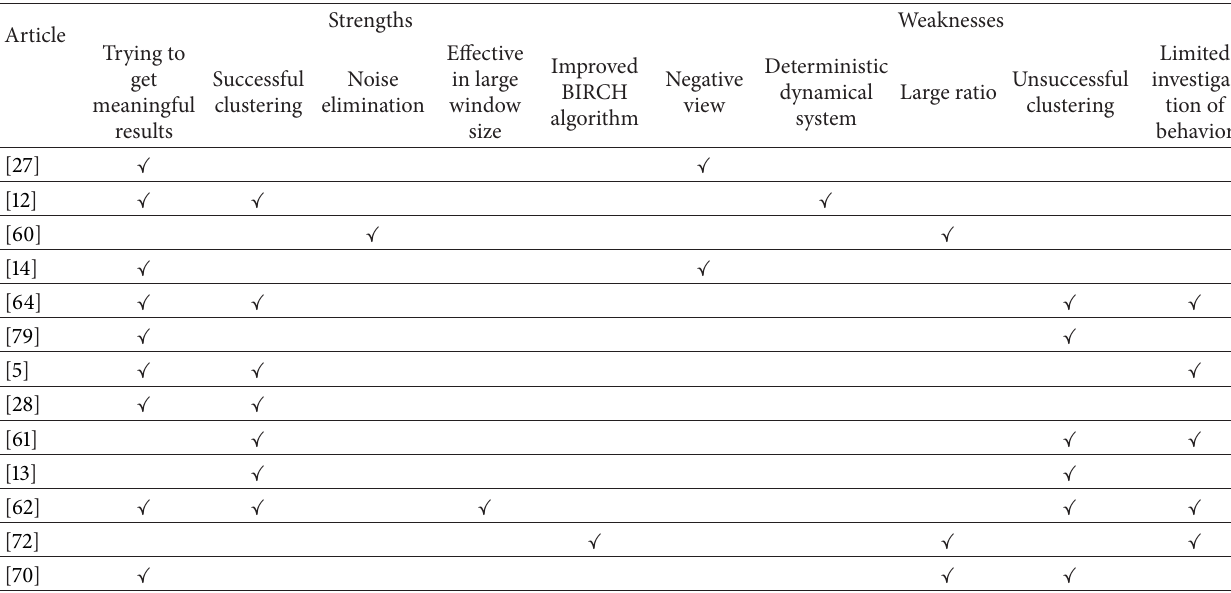
Table 5: Strengths and weaknesses of interproof period